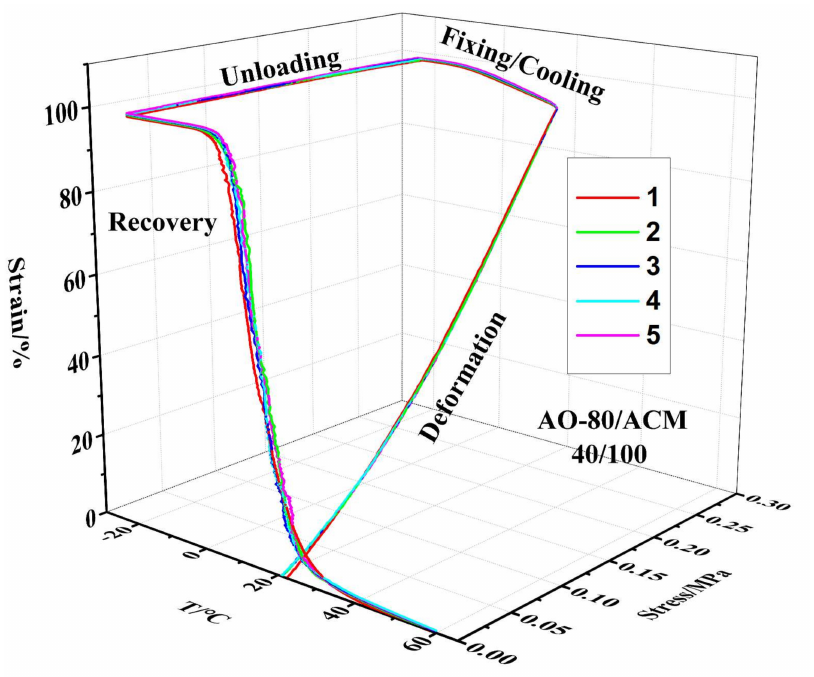
Figure 7. 3D ε -T- σ curve of five cycles for AO-80/ACM (40/100) rubber